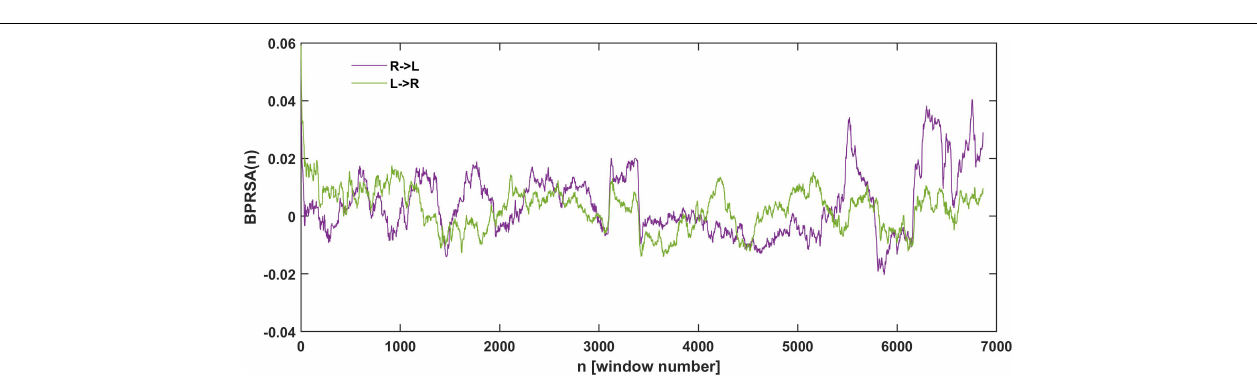
FIGURE 4 | Results of mean product σ L ( W ) · σ R ( W ) obtained for the different analyzed windows ( W ) in the initial and final segments of the trials. BEG: initial segment of the trial and END: final segment of the trial.